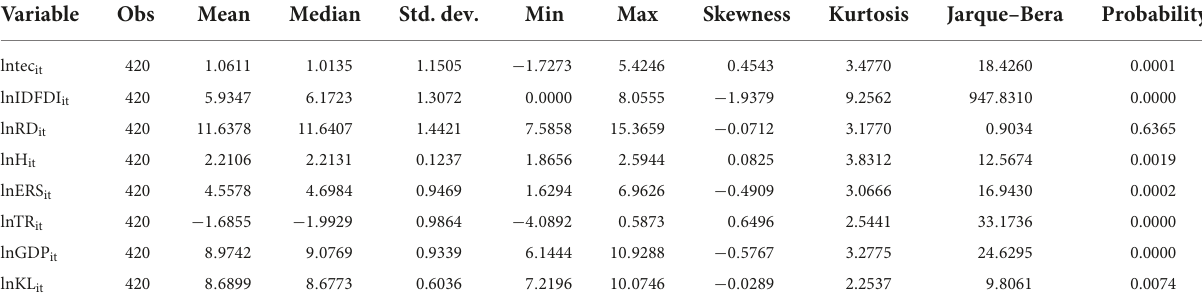
TABLE 2 Descriptive